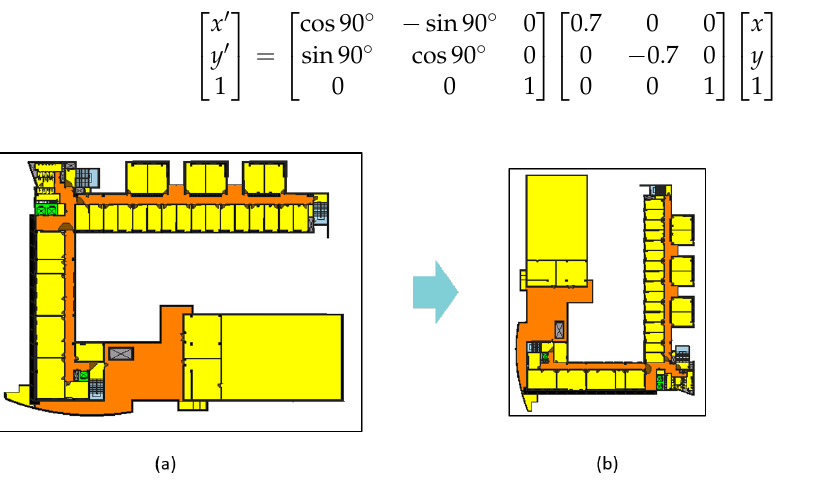
Figure 7. Example of data augmentation. The original plan ( a ) gets transformed by Equation (9), and returns an augmented plan ( b ).